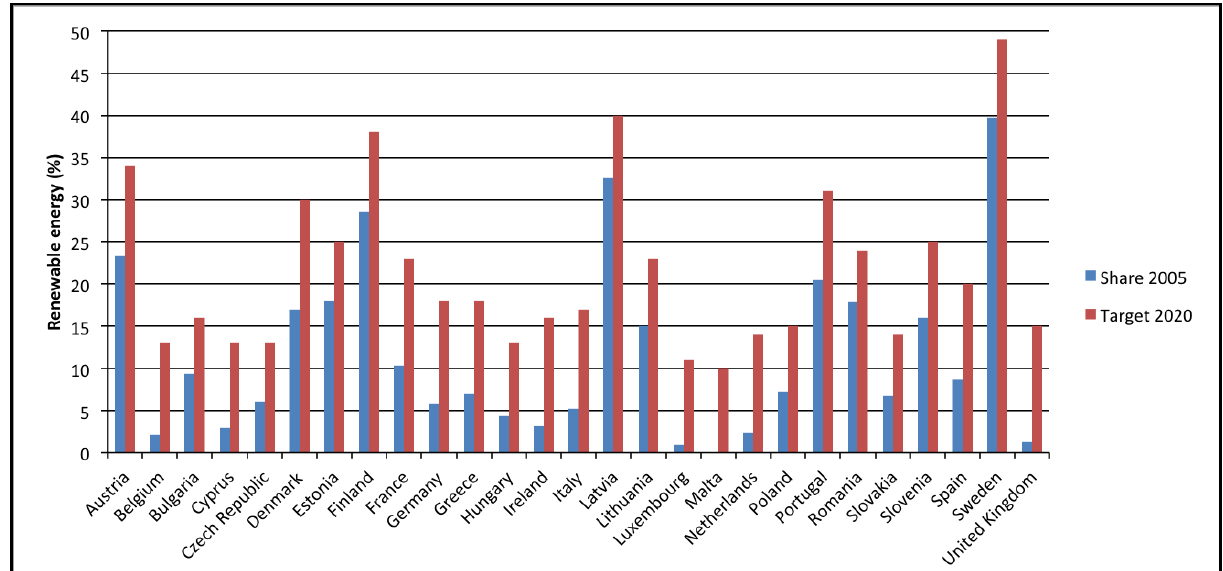
Figure 3. National proportion (%) of energy from renewable sources in gross final energy consumption in 2005 and targets (%) for the proportion in 2020 agreed upon within the European Union